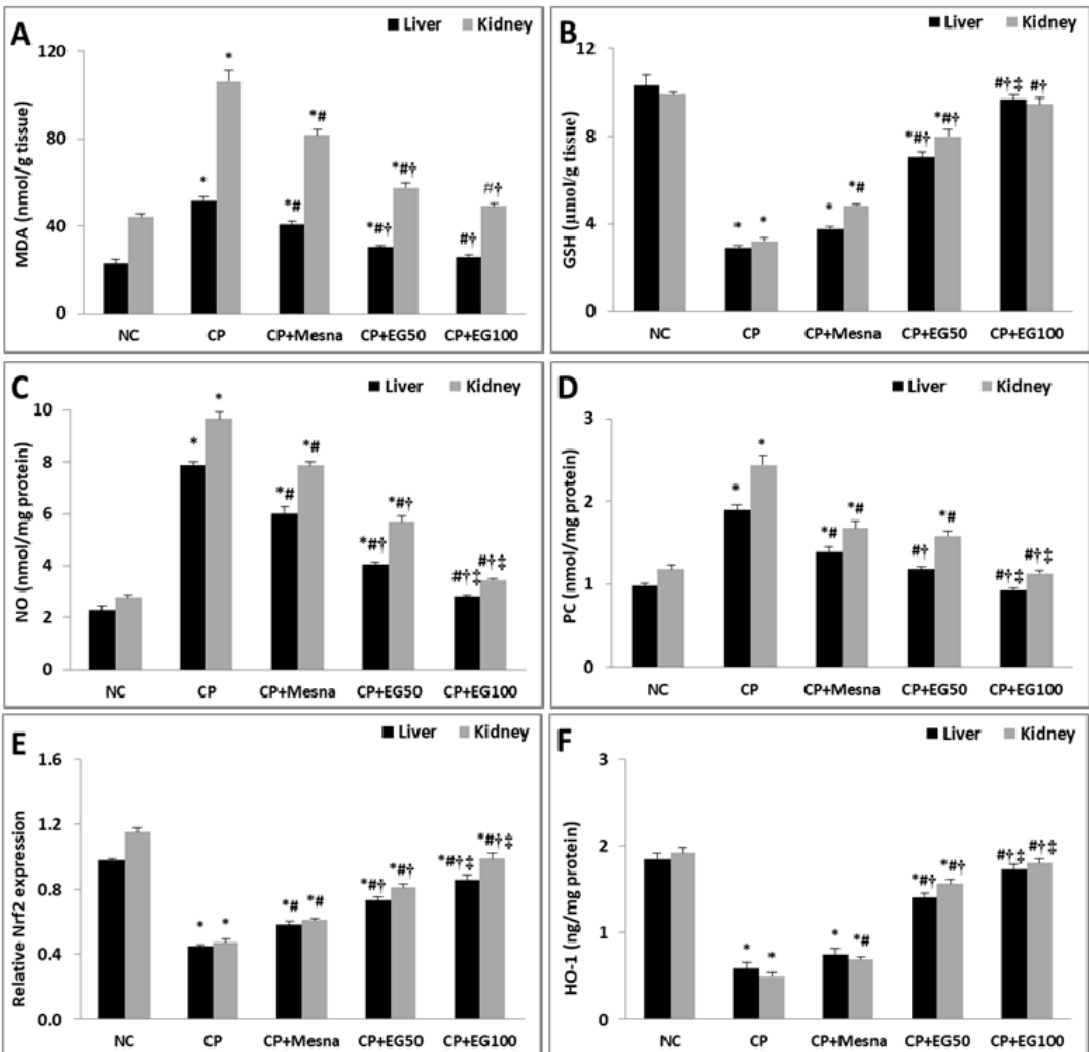
Figure 4. Effect of EG pretreatment on hepatic and renal levels of MDA ( A ), GSH ( B ), NO ( C ) and PC ( D ), on Nrf2 gene expression ( E ) and HO-1 levels ( F ) in CP-treated mice.